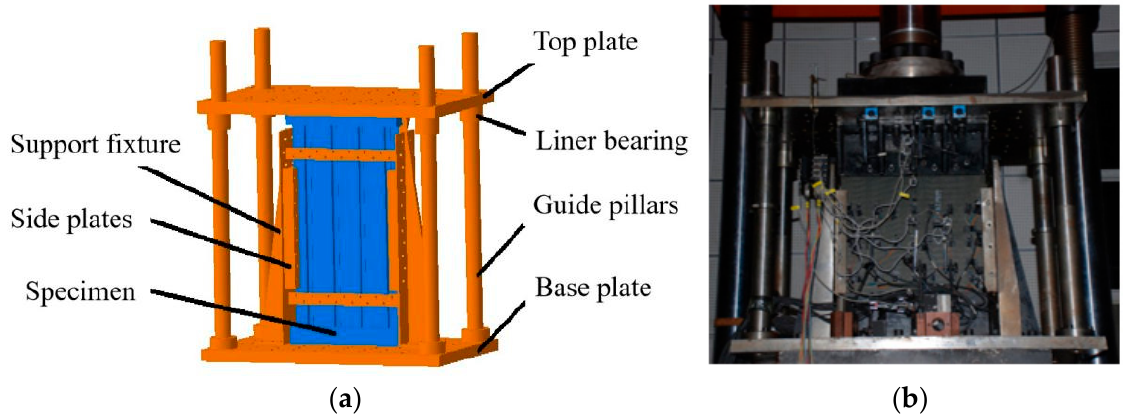
( b ) Figure 2. The impact test device and the schematic diagram of impact position. ( a ) Impact test de- vice; ( b ) Impact position. The compression tests were conducted on a hydraulic fatigue testing machine with a